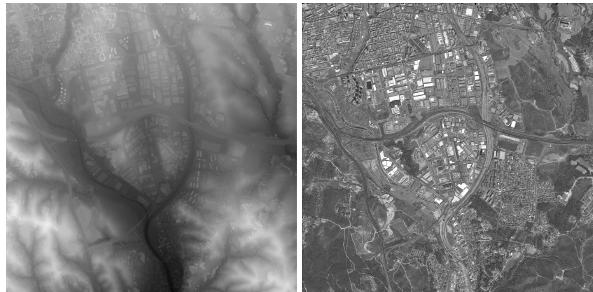
Figure 11: Overview on the Terrassa testsite, 4 km × 4 km, cen- ter at 2 ◦ 1.99’E, 41 ◦ 34.64’N, left DSM (ranging from 210 m to 390 m), right ortho image